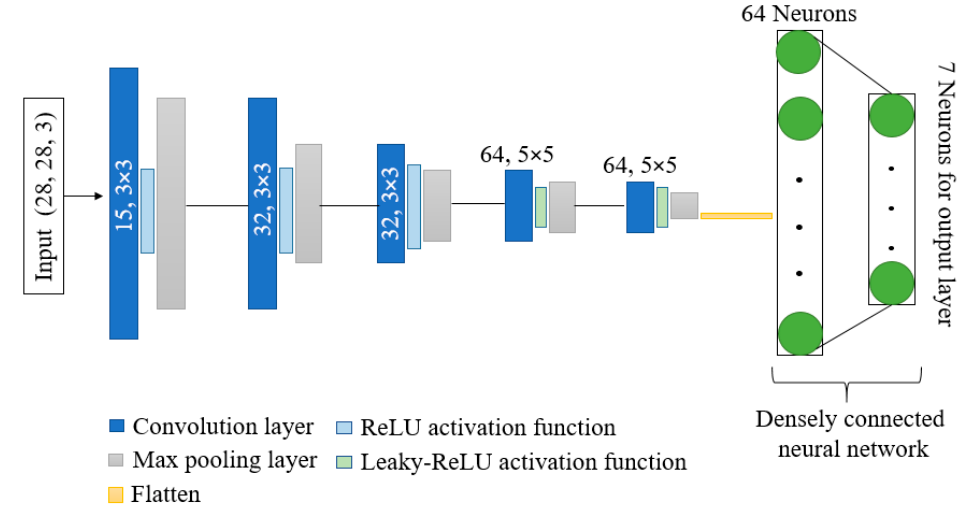
Figure 4. Architecture of proposed DKCNN model.